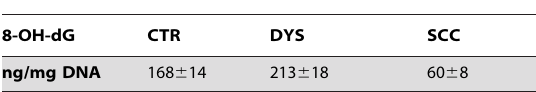
Data are expressed as mean 6 SEM.